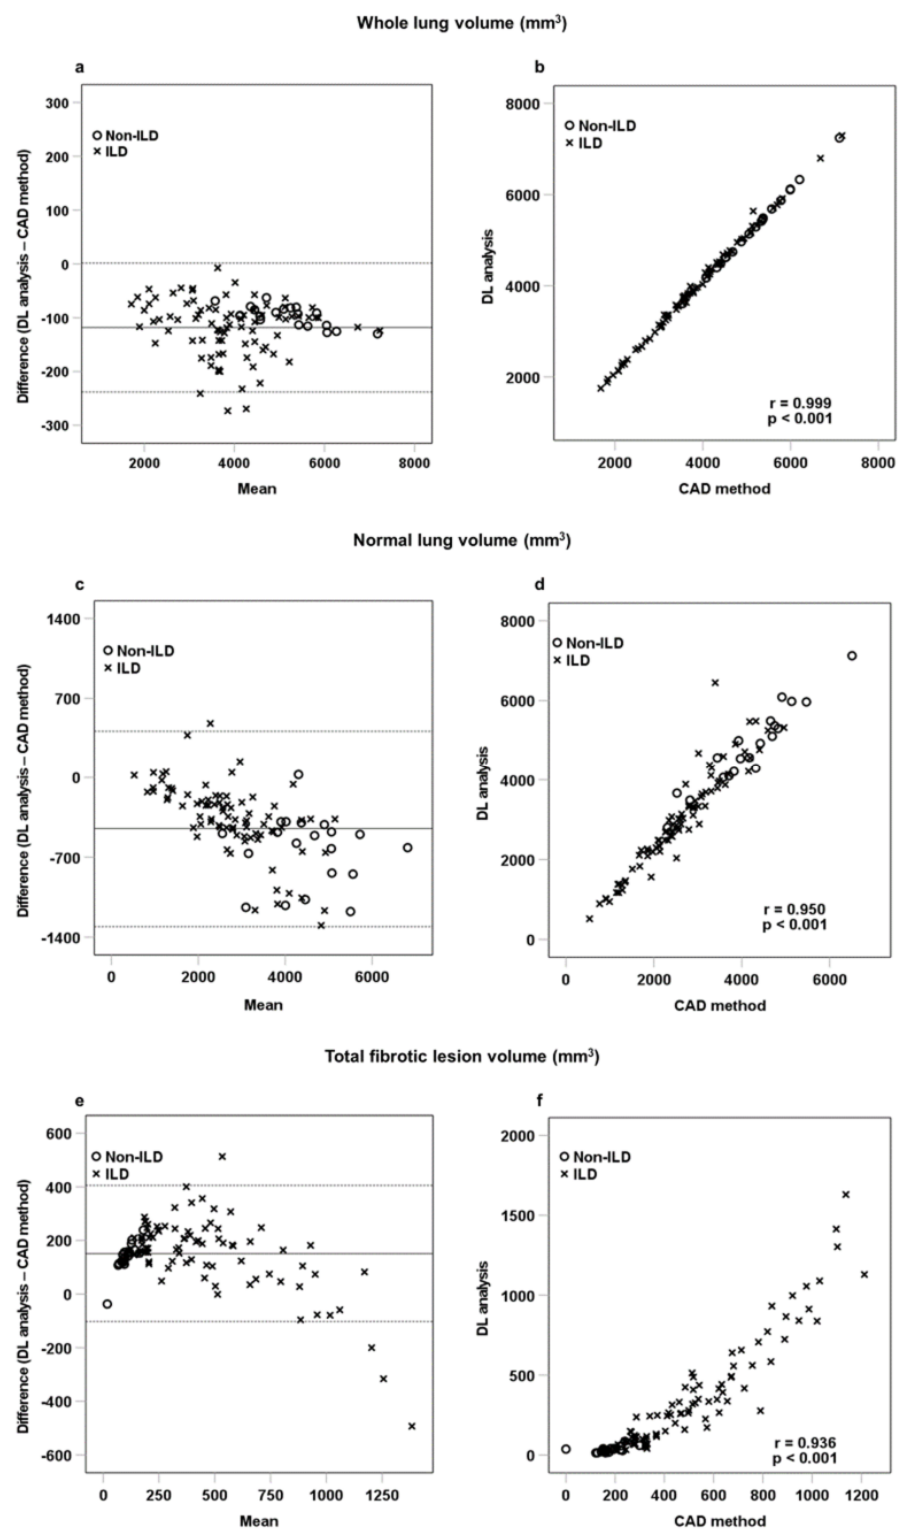
Figure 5. Bland-Altman plots and linear correlation of whole lung volume ( a , b ), normal lung volume ( c , d ), and fibrotic lesion volume ( e , f ), as determined with the CAD and DL-based methods. The black horizontal line represents the mean difference between CAD method and DL-based analysis. The dotted horizontal lines represent ±1.96 standard deviation. The difference indicates the volume as measured with the CAD method minus the volume as measured with the DL-based method.